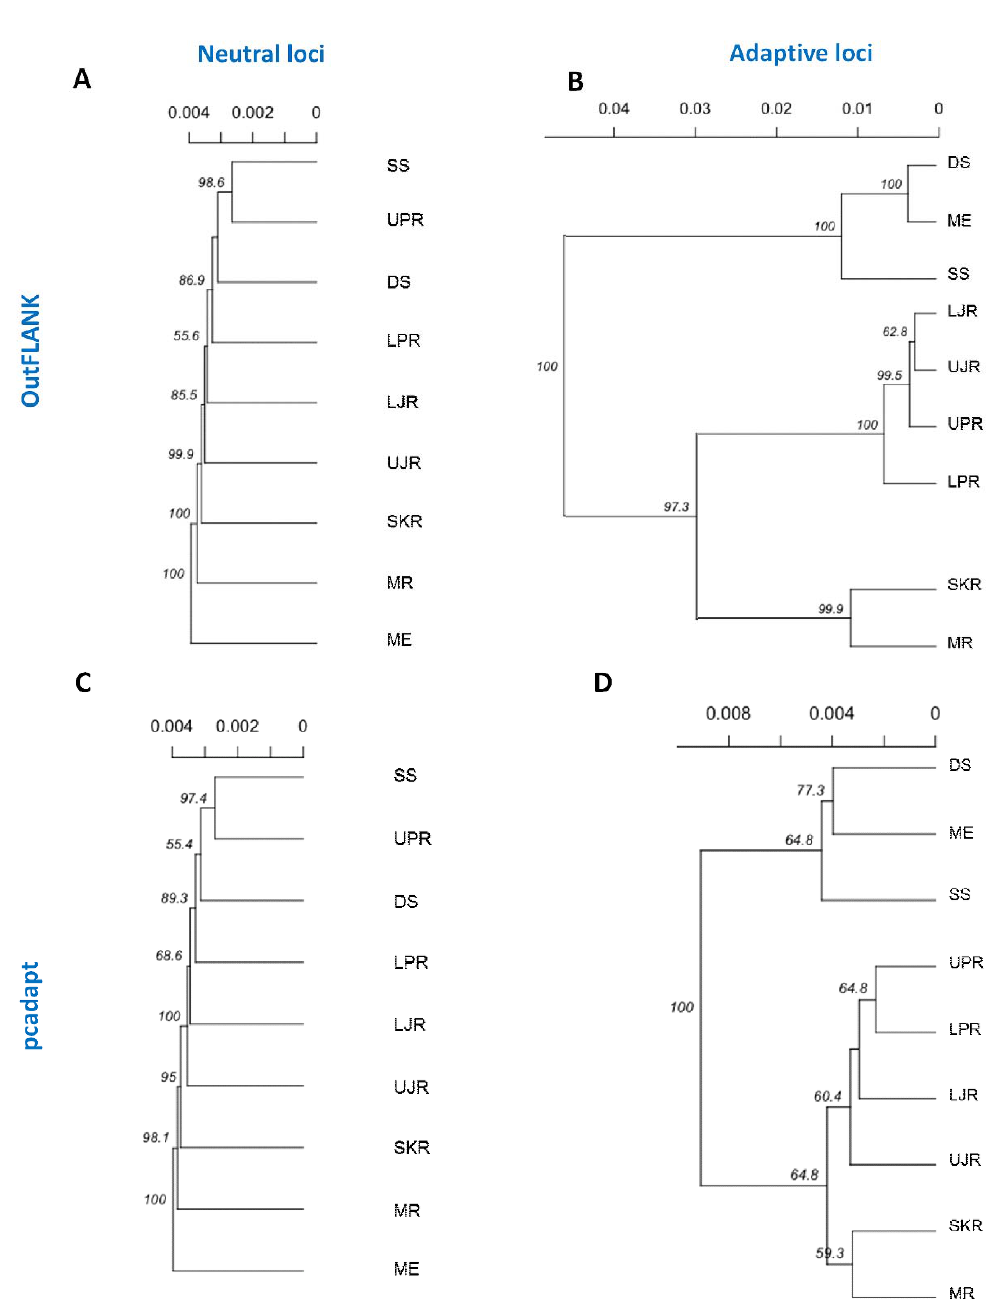
Figure 8. Neighbor-joining trees, based on the Nei’s genetic distances using the following sets of loci: ( A , B ) The putatively neutral panel of SNP loci in the F ST OutFLANK ( A ) and pcadapt approaches ( B ); and ( C , D ) the putatively adaptive panel of SNP loci in the F ST OutFLANK ( C ) and pcadapt approaches ( D ). Branch nodes are denoted as the percentage of bootstrap support, which was generated with 1000 replicates. DS, deep sea; SS, shallow sea; ME, Meghna estuary; MR, Meghna river; SKR, Surma–Kushiara river; LPR, lower Padma river; UPR, upper Padma river; LJR, lower Jamuna river; UJR, upper Jamuna river.